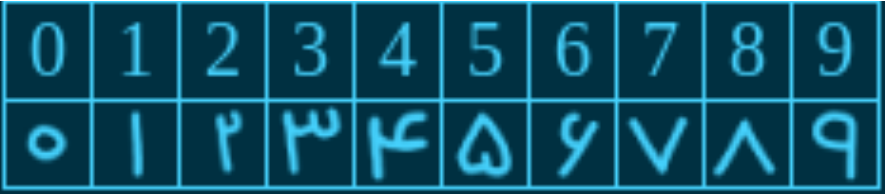
Figure 9. HODA representations for Arabic digits are demonstrated